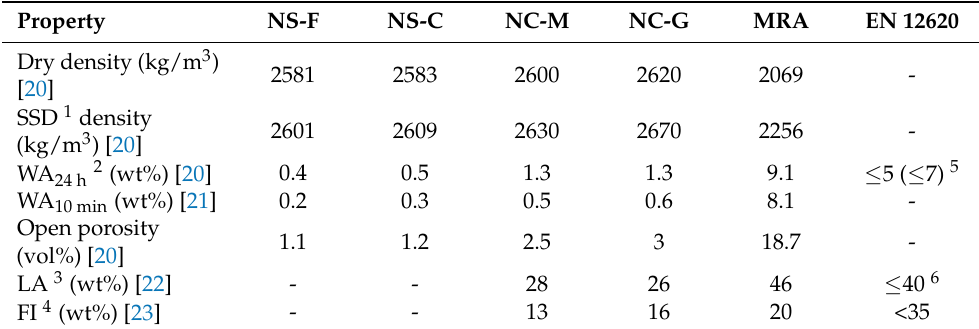
Table 3. Physical and mechanical properties of the